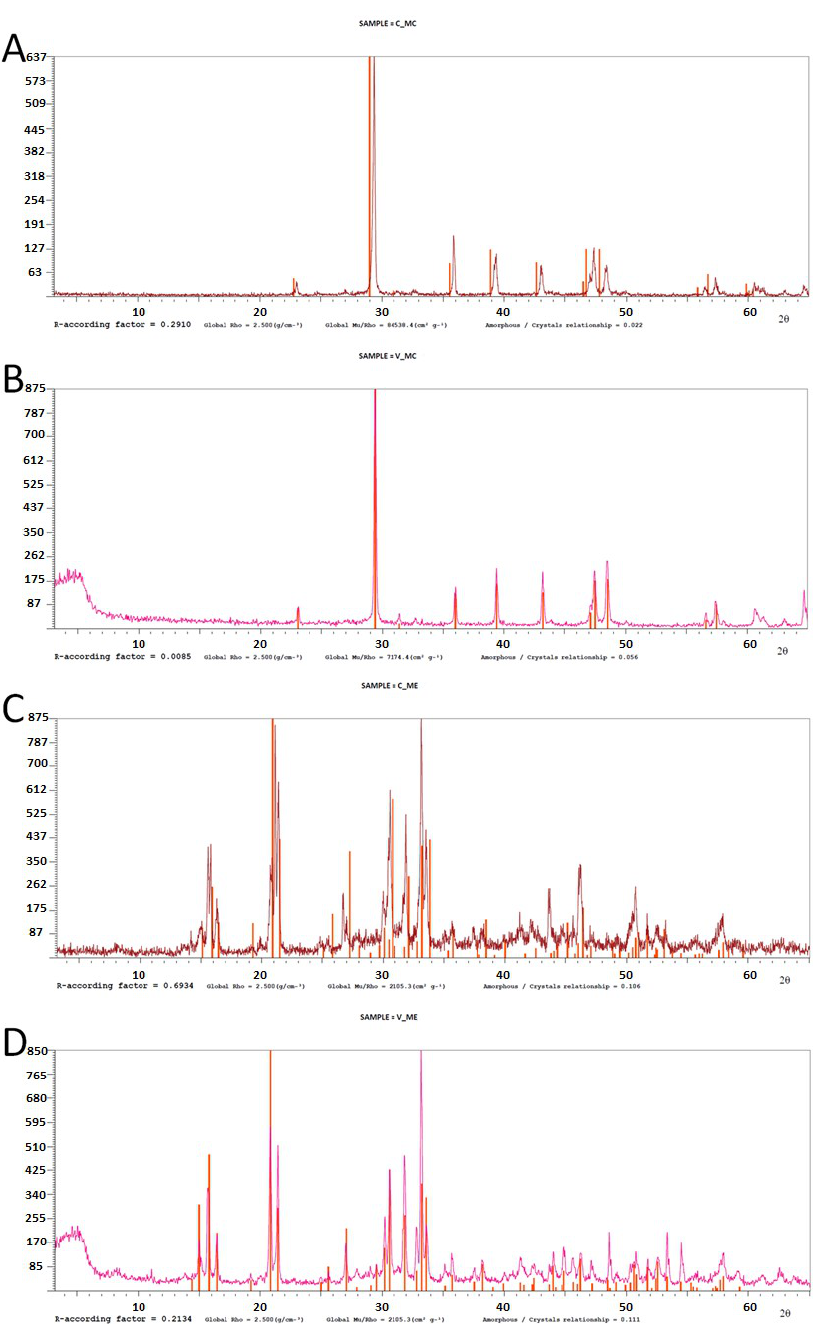
Figure 7. X‐Ray diffractometry analyses of biominerals precipitated in the culture media: ( A ) MC medium for constant salinity conditions, ( B ) ME medium for constant salinity conditions, ( C ) MC medium for variable salinity conditions, and ( D ) MC medium for variable salinity conditions. 3.6. Identification of Bacterial Species Associated with Mineral Precipitation from the Biofouling Formed under Constant-Salinity and Variable-Salinity Conditions Only one bacterial species, classified as Citrobacter freundii and associated with calcite precipitation capacity, was detected in MC medium for the constant salinity condition while, in ME